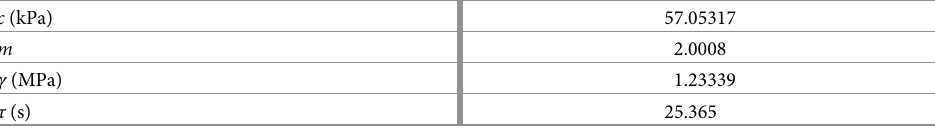
Table 1. Optimised material parameters for finite element models.